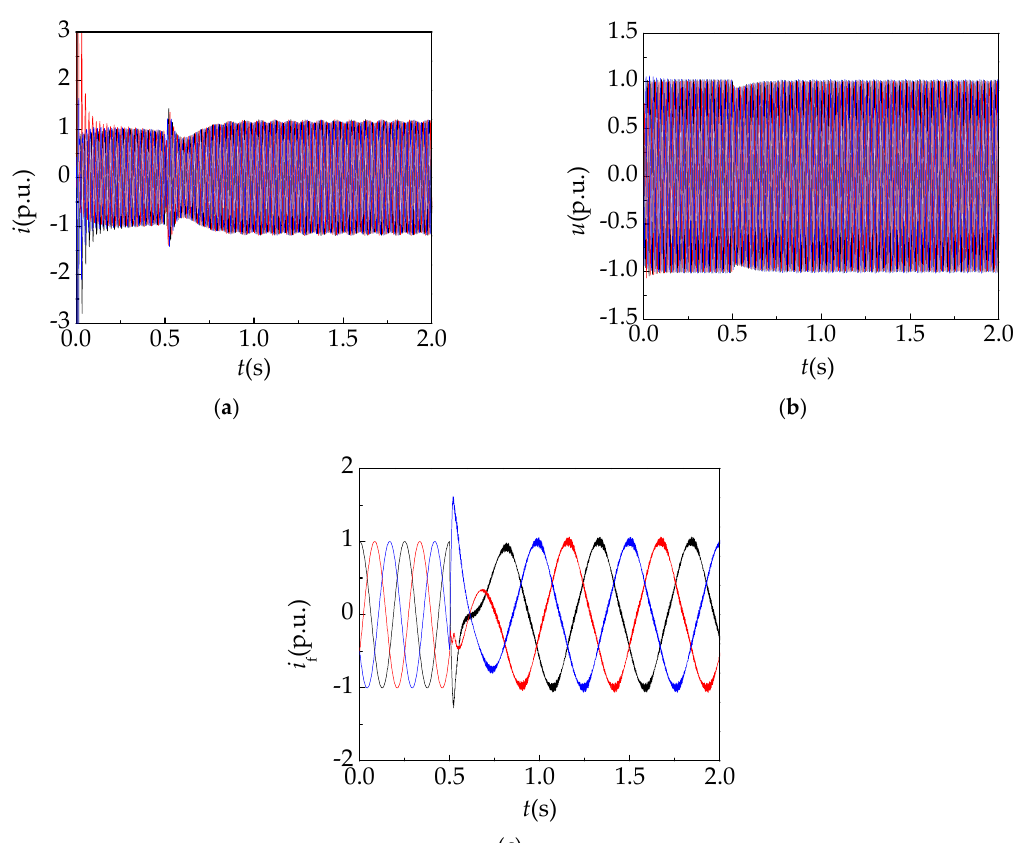
Figure 9. The waveforms of electrical quantities after the three phase short-circuit loss of excitation in the subsynchronous operation state ( s = 0.08): ( a ) Stator current; ( b ) stator induced voltage; ( c ) rotor current.